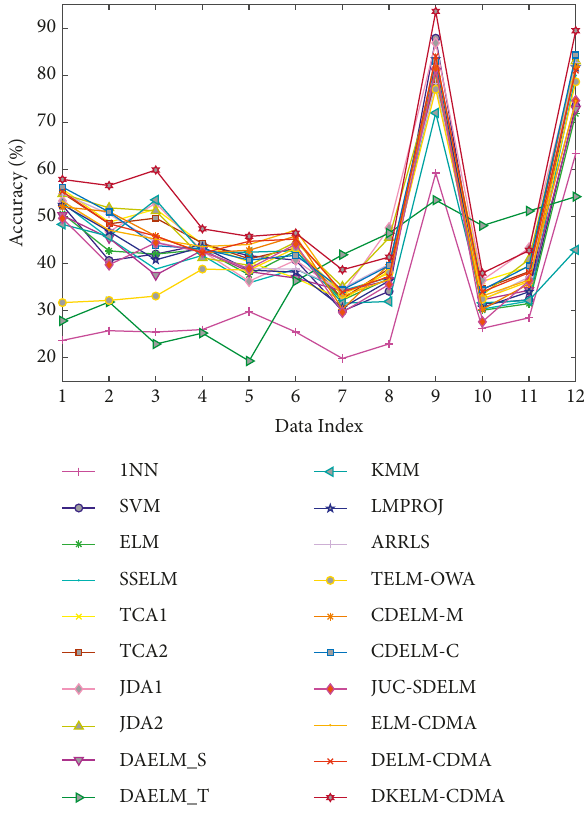
Figure 7: Classification accuracy of different algorithms on offi- ce +caltech data